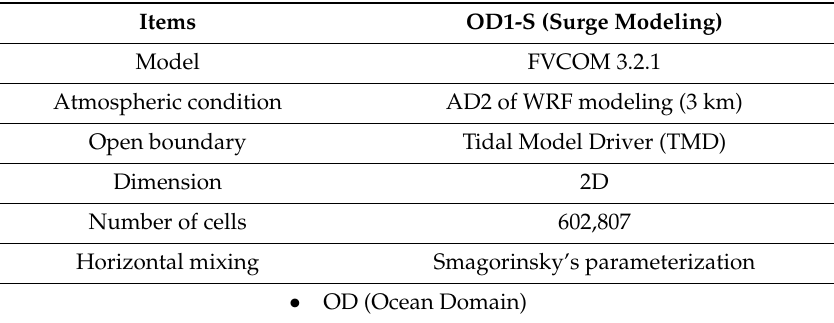
Table 2. Model description of the